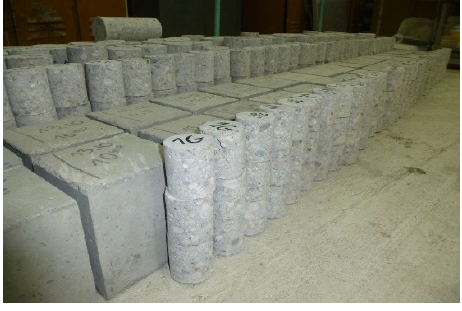
Figure 3. Storing of the core and cubic sample.